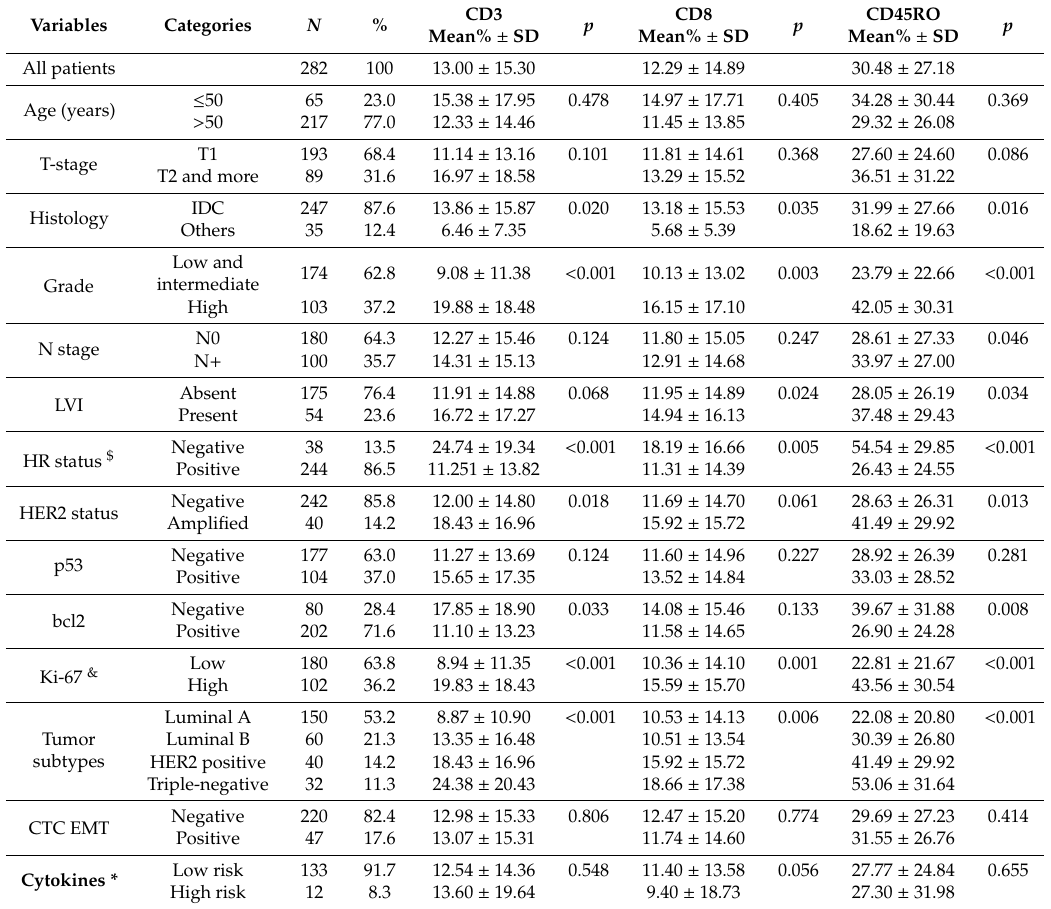
Table 1. Mean values of studied TILs stratified by clinicopathological